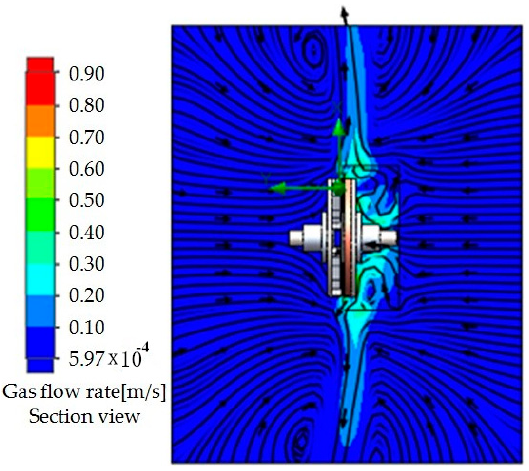
Figure 5. Distribution of air velocity at the center section of a magnetic coupling.